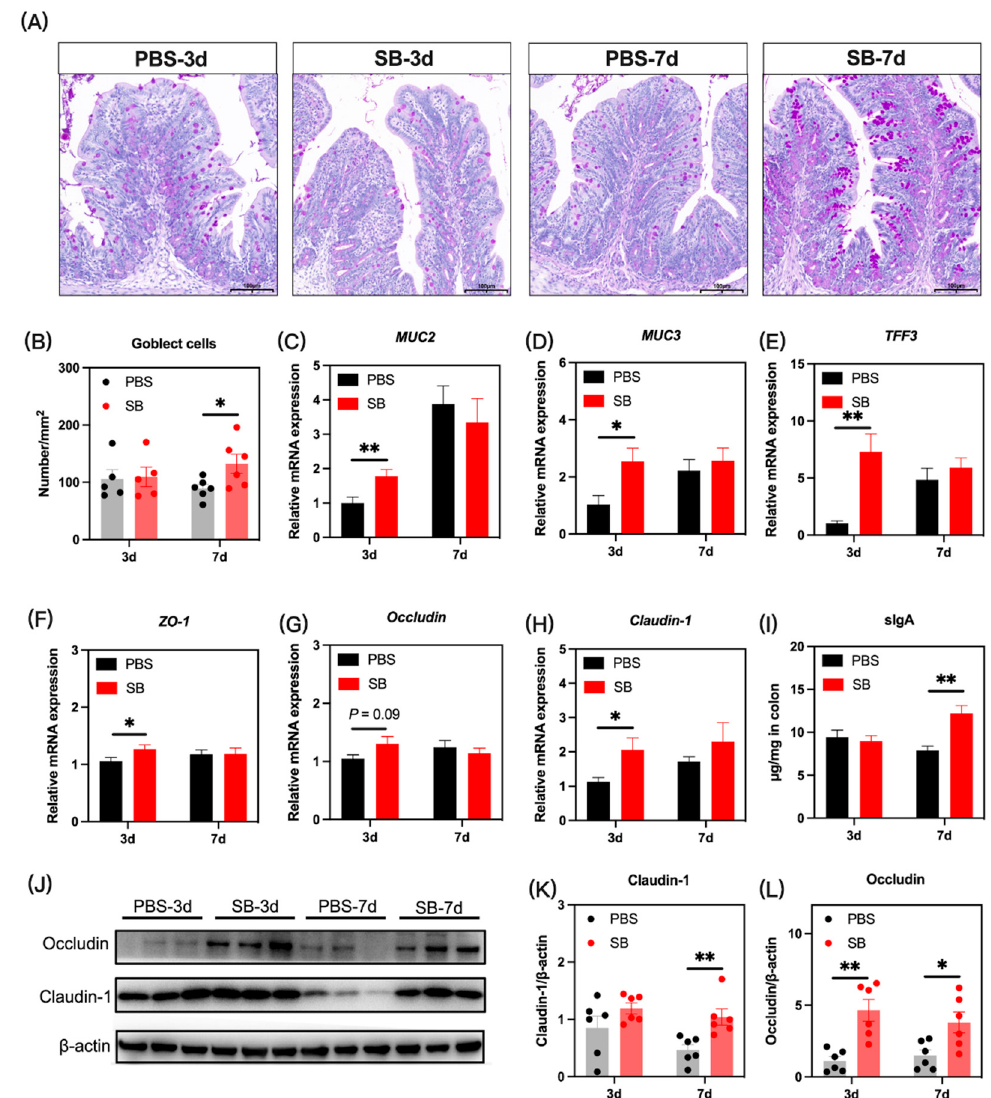
Figure 8. Effects of S. boulardii early intervention on the mucosal barriers. ( A ) Representative images of PAS-stained colonic sections. Scale bar = 200 µ m. ( B ) The number of goblet cells in the colon. The relative mRNA expression of the gene for MUC2 ( C ), MUC3 ( D ), TFF3 ( E ), ZO-1 ( F ), Occludin ( G ), and Claudin-1 ( H ). ( I ) The concentration of sIgA in the colon. ( J ) The protein expression of Claudin-1 ( K ) and Occludin ( L ). Values are expressed as mean ± SEM, n = 5–12. * p < 0.05, ** p < 0.01. d, day. PBS, rats early intervened with phosphate buffer solution. SB, rats early intervened with S. boulardii . MUC2, mucin2. MUC3, mucin2. TFF3, trefoil factor family 3. ZO-1, zonula occluden 1. sIgA, secretory immunoglobulin A.